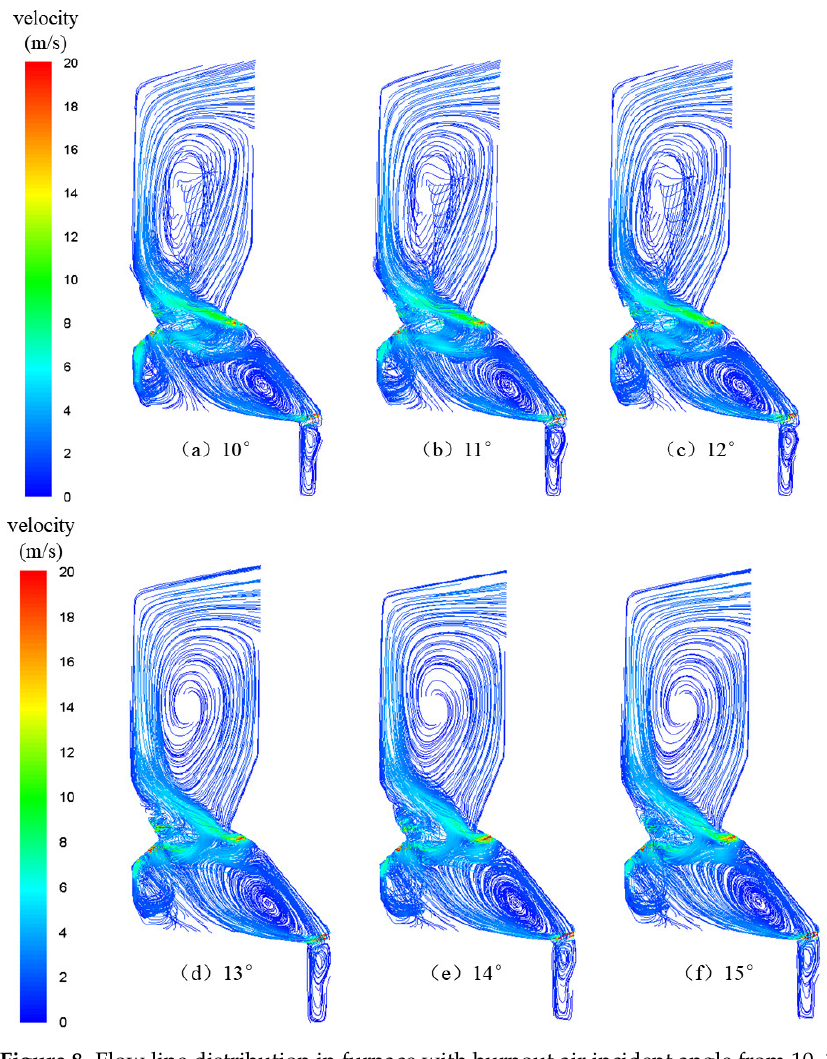
Figure 8. Flow line distribution in furnace with burnout air incident angle from 10–15°.